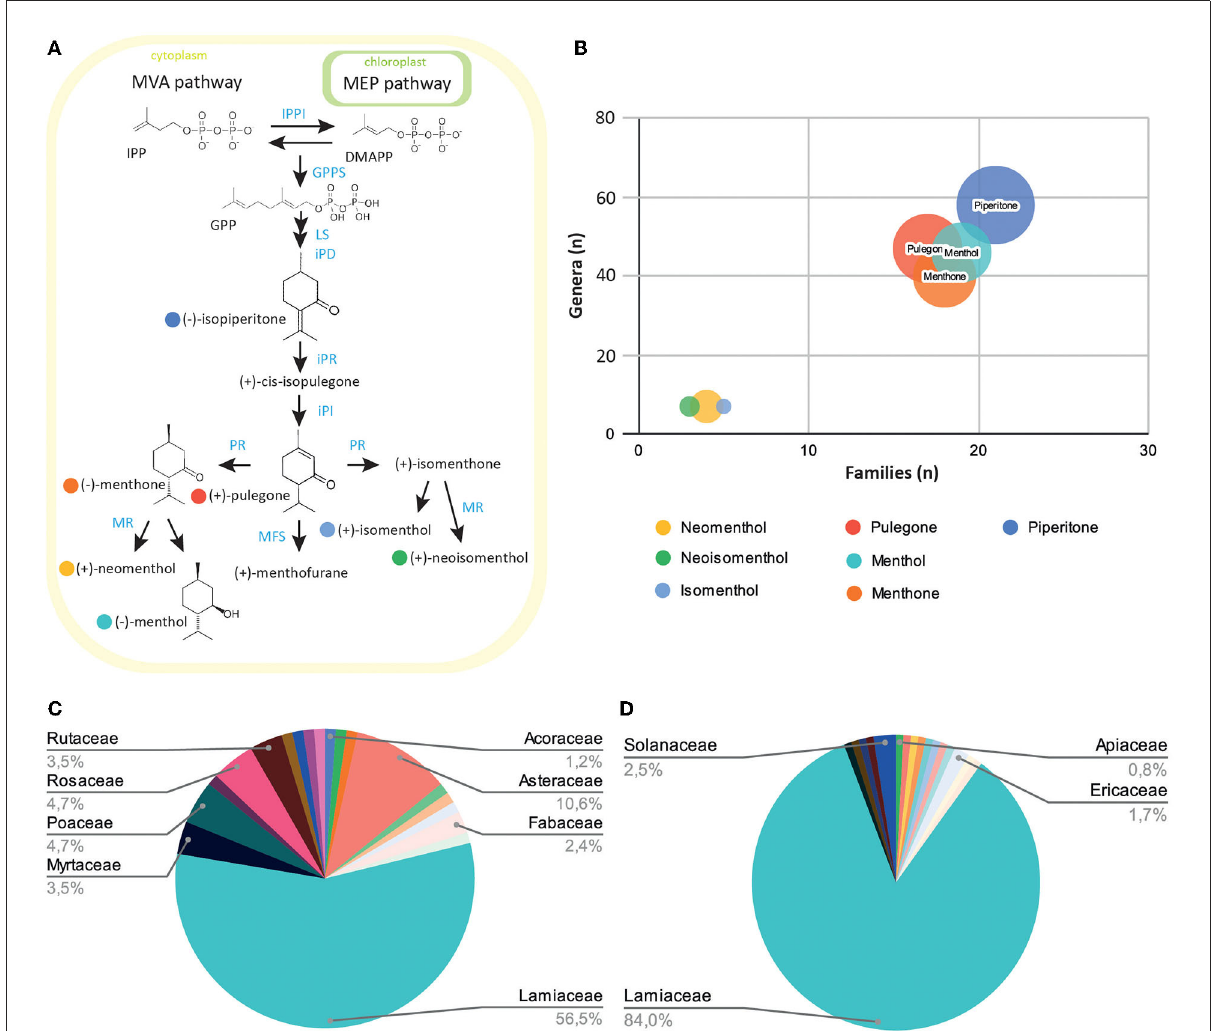
FIGURE1 Exploration of the prevalence of menthol-like monoterpenes across the plant kingdom. (A) Schematic view of the monoterpene biosynthesis pathway leading to menthol, pulegone, and their derivatives. Plants produce the small precursor isopentenyl-pyrophosphate (IPP) through the mevalonate (MVA) pathway in the cytoplasm, or the methylerythritol (MEP) pathway in the plast. IPP can be isomerized into dimethylallyl-pyrophosphate (DMAPP) through the IPP isomerase activity (IPPI). Five-carbon units IPP and DMAPP can be converted into 10-unit geranyl-pyrophosphate (GPP) through the geranyl-pyrophosphate synthase (GPPS) activity. GPP is then converted into limonene, isopiperitone, and cis-isopulegone through limonene synthase (LS), trans-isopiperitenol dehydrogenase (iPD), and isopiperitone reductase (iPR) activity. Pulegone is then produced through cis-isopulegone isomerase (iPI) activity. Pulegone reductase (PR) converts pulegone into isomenthone or menthone, through different activities. These two compounds can then be converted into neomenthol and menthol, or isomenthol and neoisomenthol, respectively, through the menthone reductase activity (MR). The menthofurane synthase (MFS) can also convert pulegone into menthofurane, in an NADP-dependant reaction. (B) Bubble diagram representing the number of families (x-axis), genera (y-axis), and species (circle radius) containing monoterpenes precursors or derivatives. (C) Diagram of the distribution of menthol-containing plants within plant families. (D) Diagram of the distribution of pulegone-containing plants within plant families.